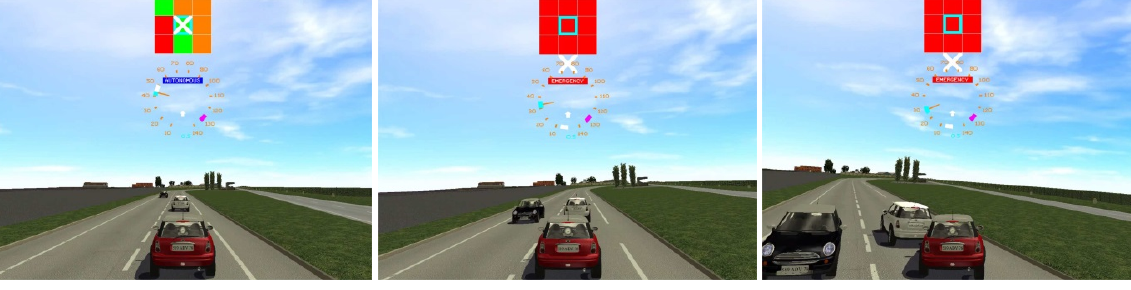
Figure 19. Example of critical